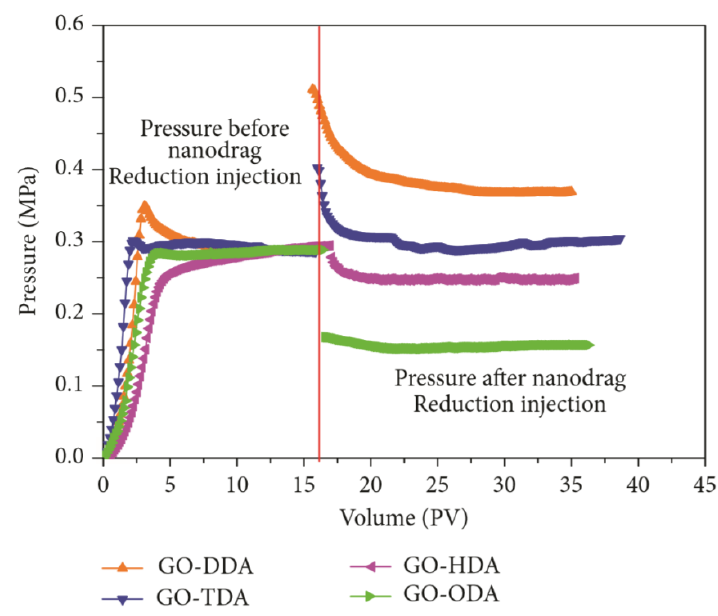
Figure 4. Pressure of water flooding before and after nano drag reducer injection [90].